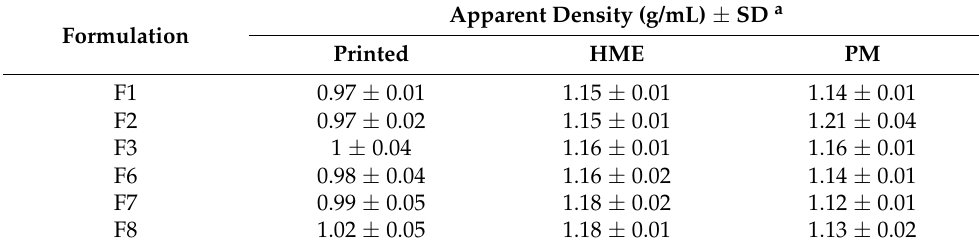
Table 7. The apparent density of tablets made via different